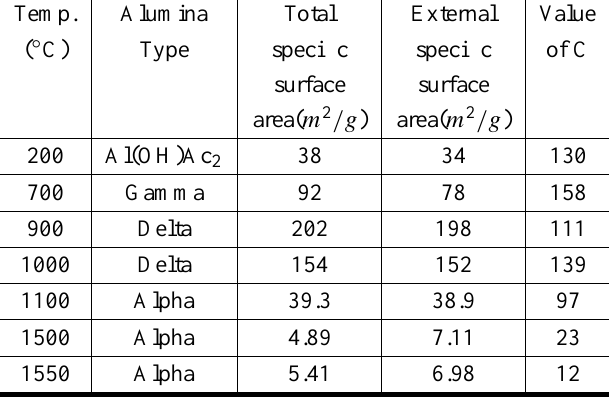
Surface areas and values of C of the Aluminas formed from heating Al(OH)Ac 2 at several